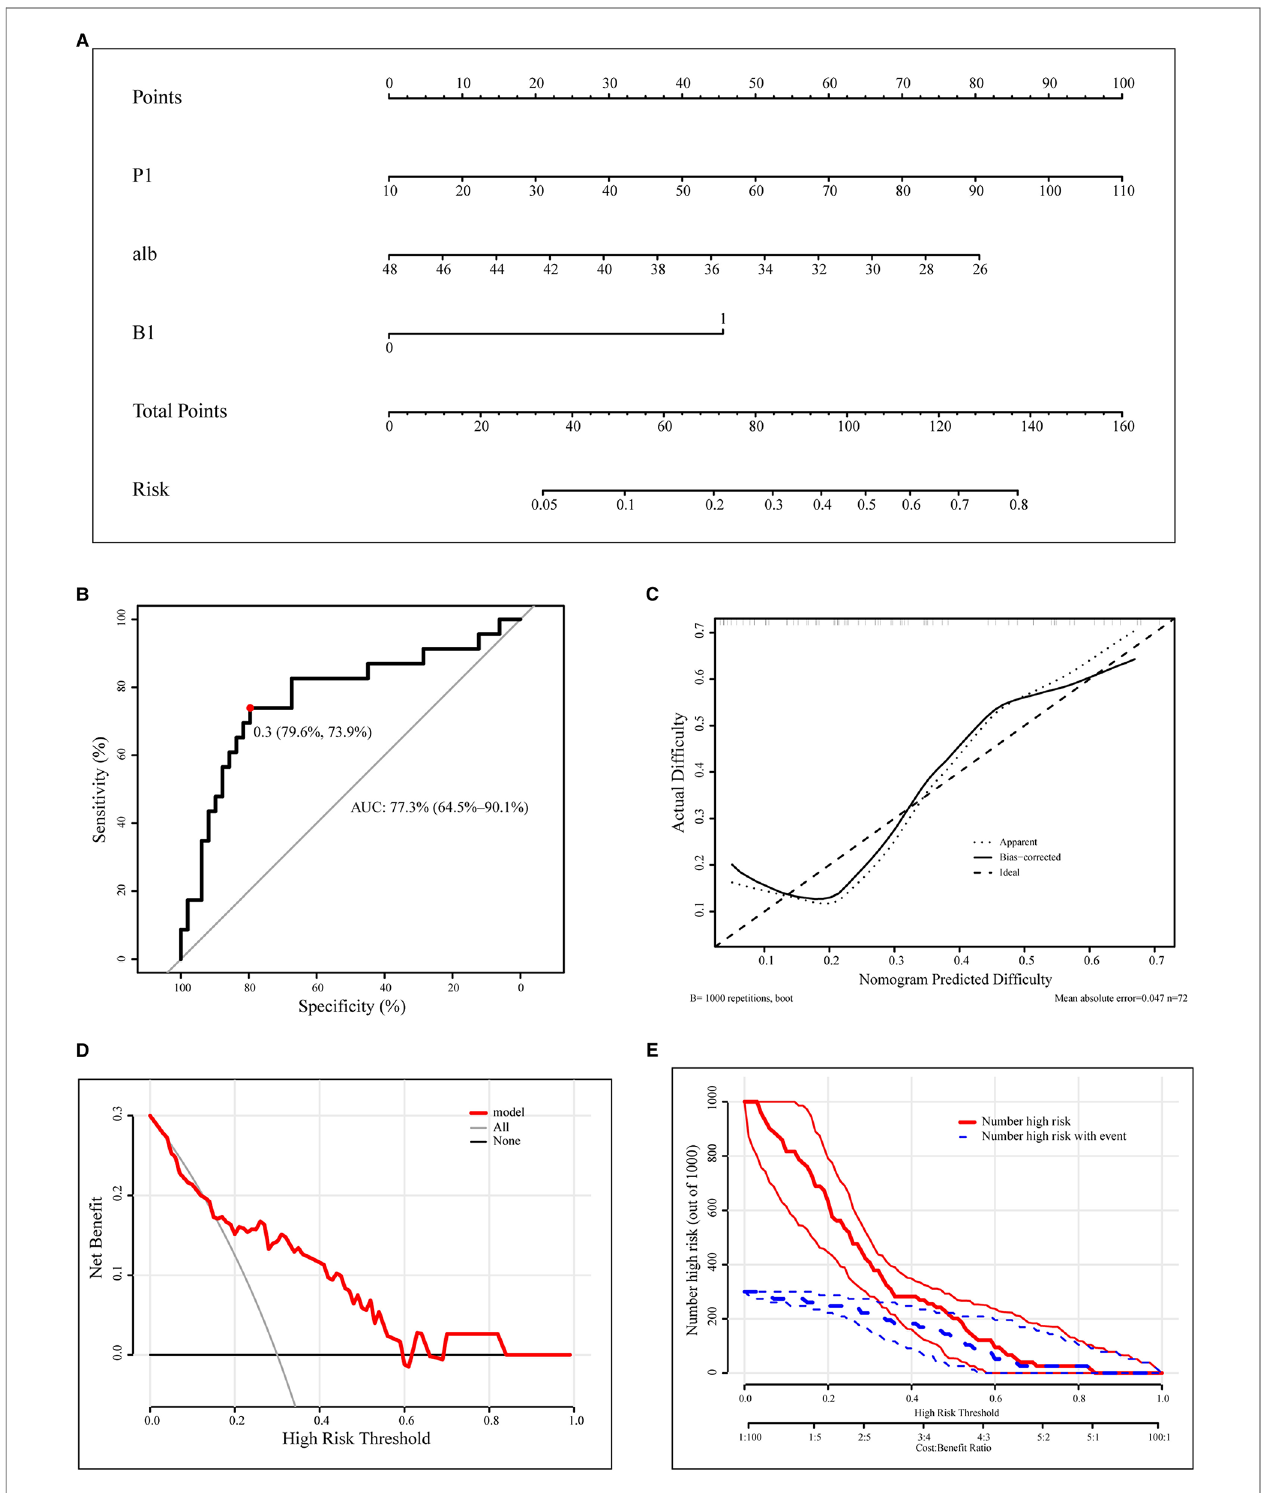
FIGURE 5 | Construction and calibration of nomograms for RPD that integrates pathological features and anatomical factors. ( A ). Development of the nomogram to predict the dif fi culty of RPD. ( B ). ROC curve of the nomogram model. ( C ). Calibration curve of the nomogram. ( D ). DCA curve. ( E ). CIC curve. RPD, robotic pancreatoduodenectomy; ROC, receiver operating characteristic curve; DCA, decision curve analysis; CIC, clinical impact curve; alb, preoperative albumin.